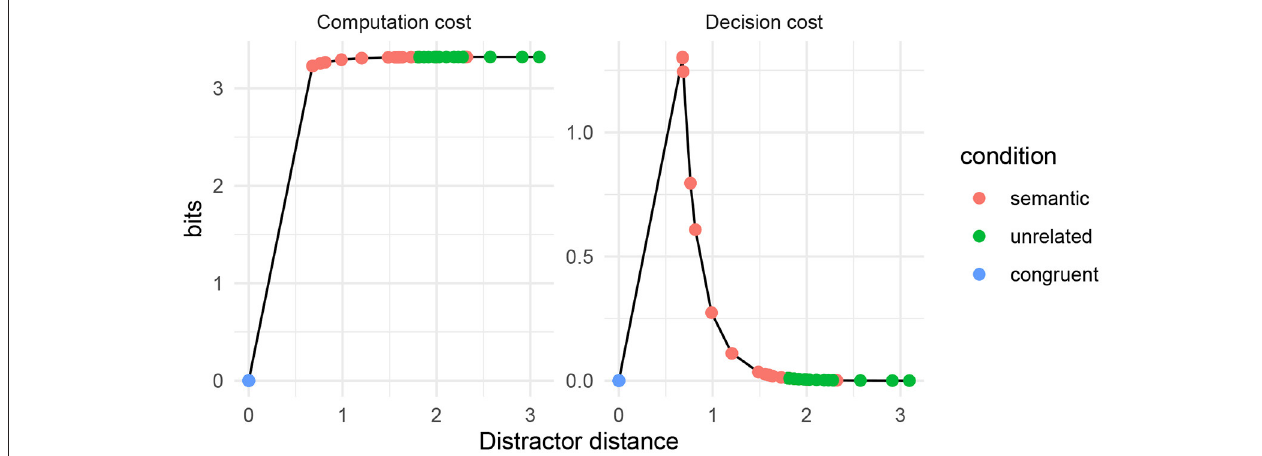
FIGURE 7 | Computation and decision costs for word pairs from the items of Roelofs and Piai (2017), using fastText as the semantic distance metric.